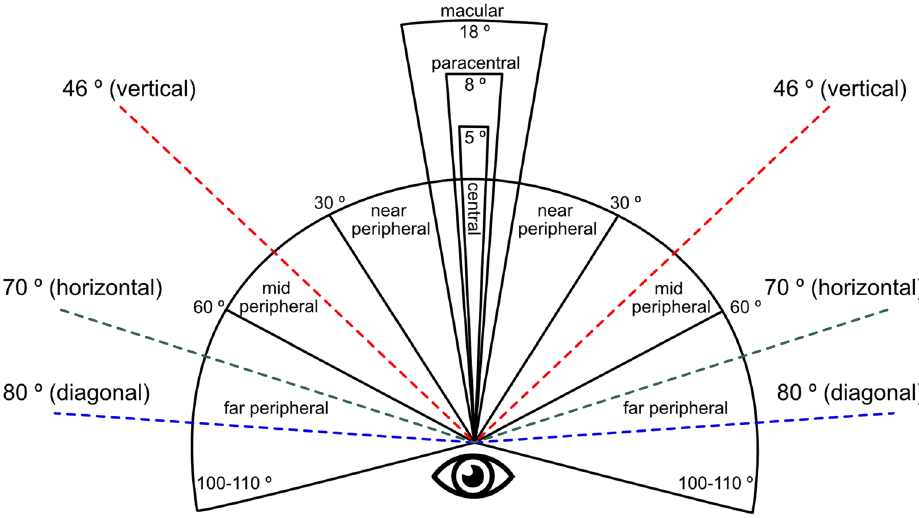
Figure 3. The scope of human vision 48 . The dashed lines represent the angular distances we use in subjective experiments (“Subjective experiment”